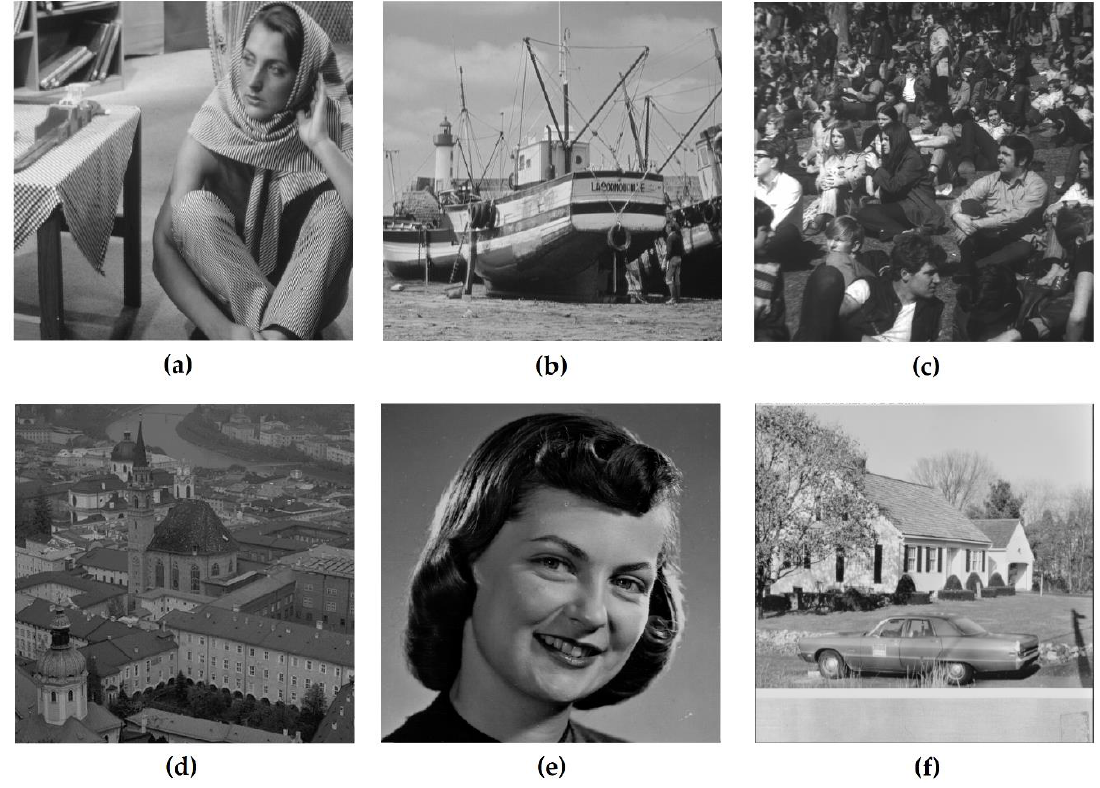
Figure 6. Test images: ( a ) Barbara; ( b ) Boat; ( c ) Crowd; ( d ) Town; ( e ) Girlface; ( f ) Car.